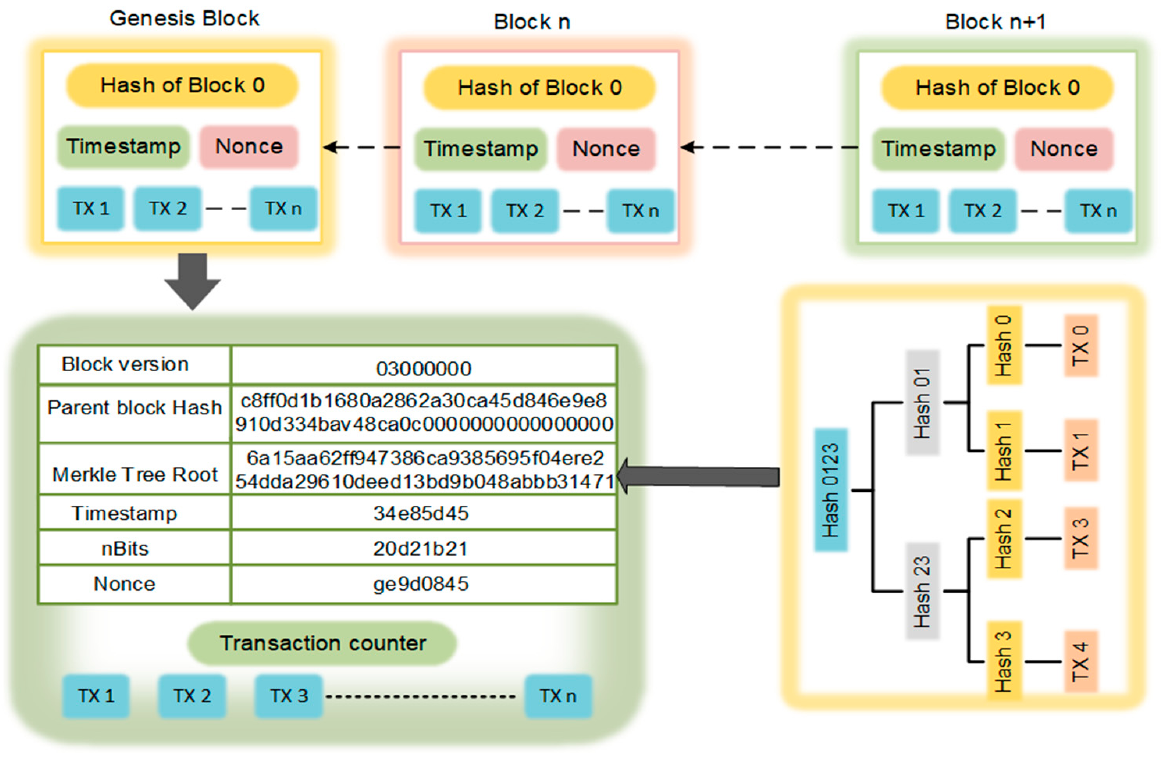
Figure 2. Block structure.